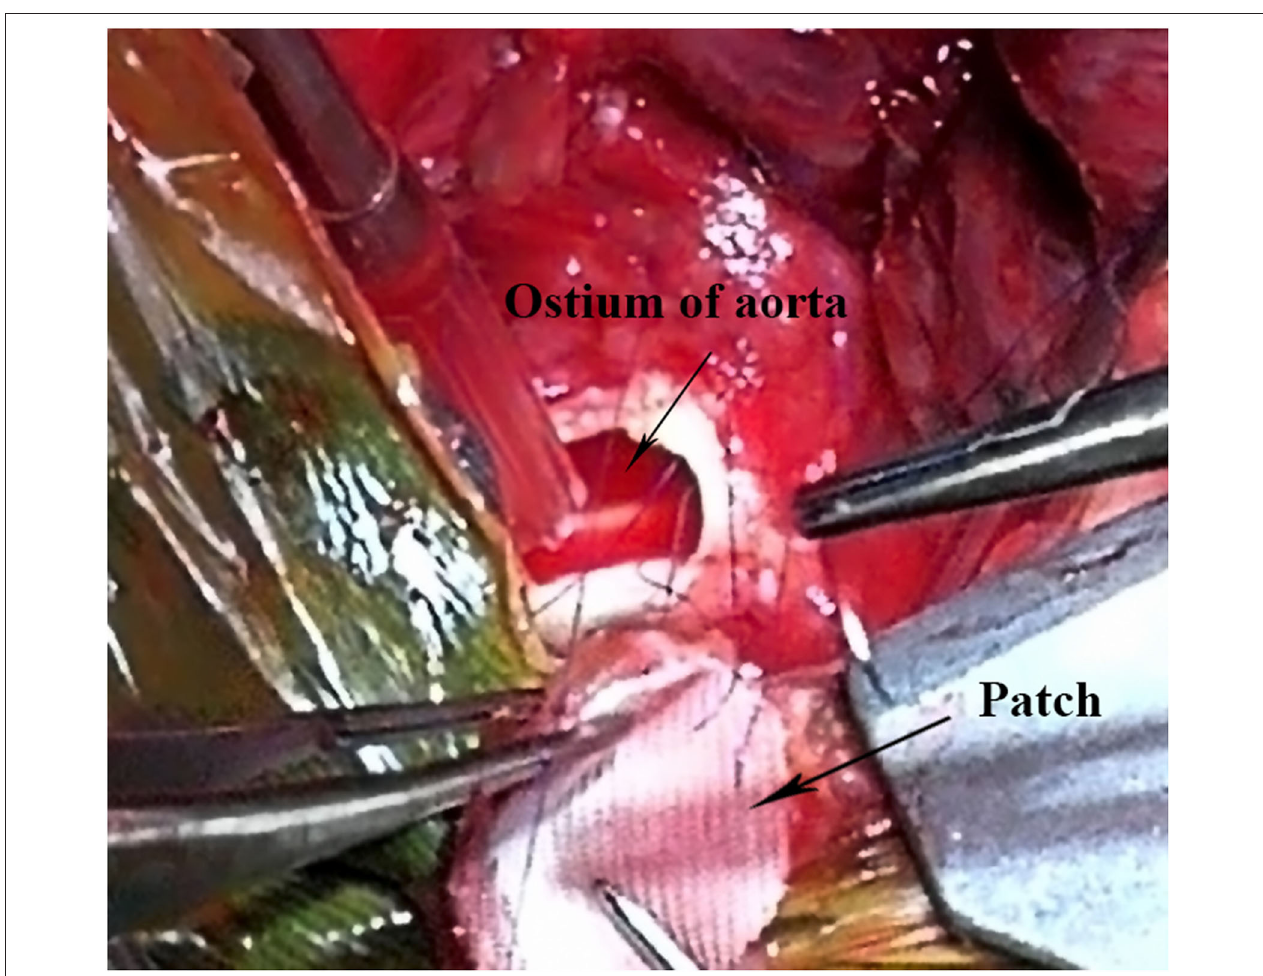
FIGURE 4 | Intraoperative image demonstrates the ostium of aorta and the double layer patch used to repair the